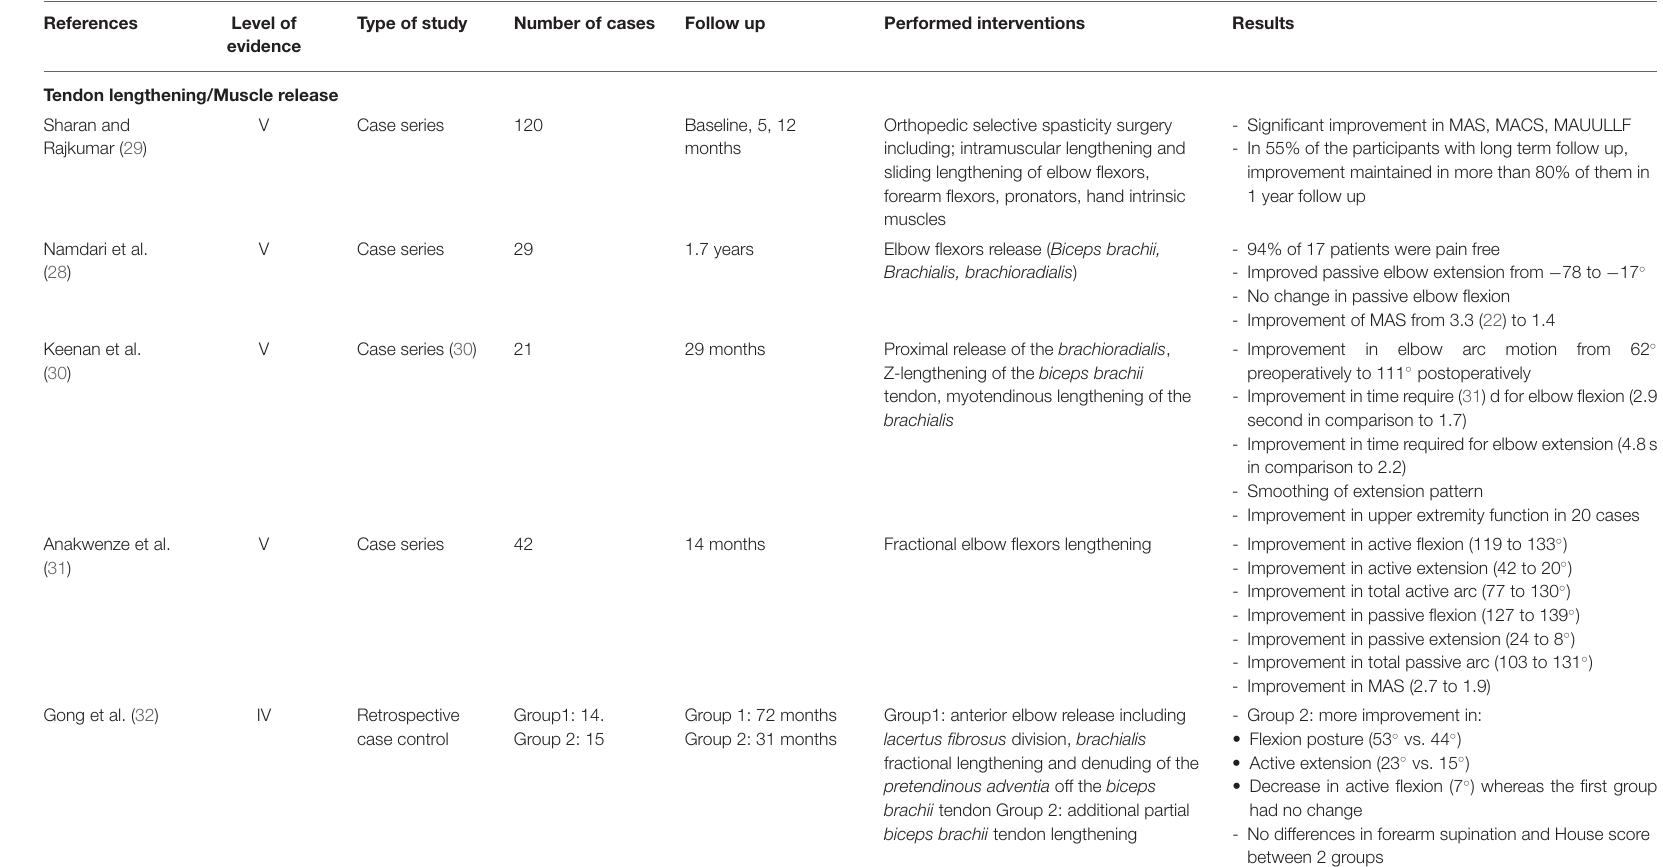
TABLE 2 | Summary of articles for surgical approaches to a spastic